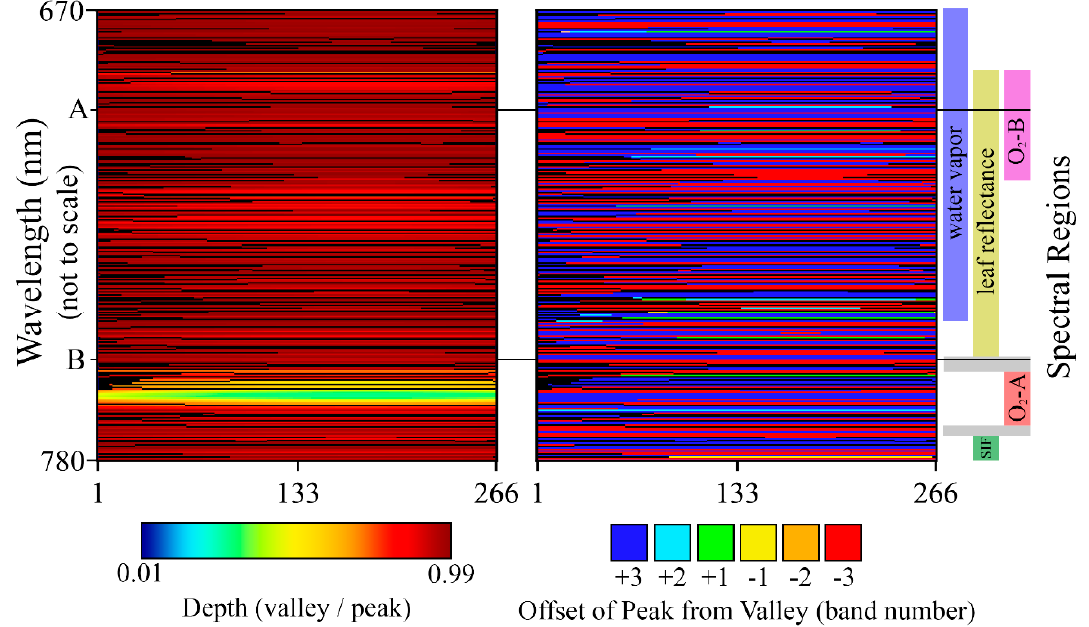
Figure 20. The absorption features identified in simulated FIREFLY spectra are arranged according to their wavelength (resulting in the wavelength axis being not to scale). The proportional depth (left plot) and valley to peak band distance (right plot) for each feature in each spatial pixel is shown. A black point indicates that the absorption feature was not present in that spatial pixel. The spectral regions relevant to SIF retrieval (see Figure 16) are drawn to the right of the plots, and are scaled to match the wavelengths of the absorption